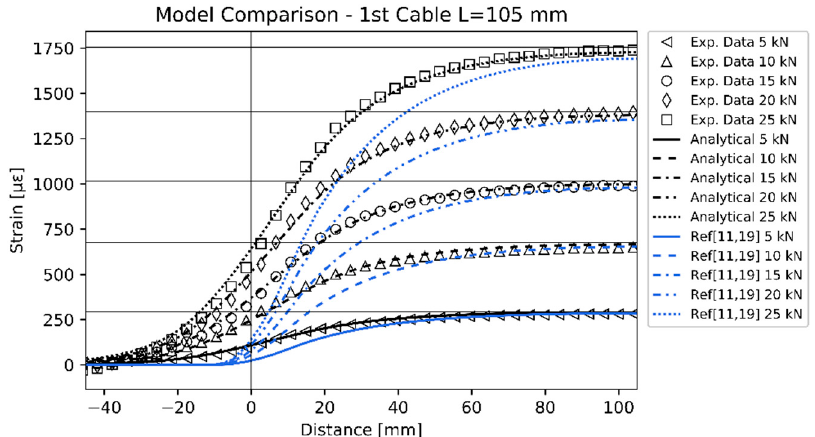
Figure 9. Comparison between the novel analytical model, experimental data and analytical models of references [11,19] using k = 0.049 mm − 1 and neglecting the reciprocal interaction with the specimen.